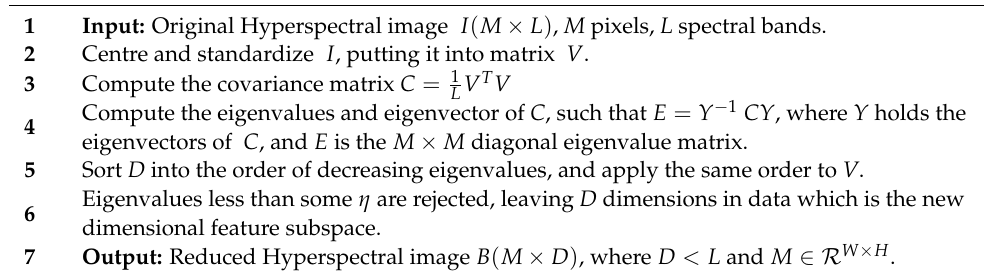
Algorithm 1: Principle Component Analysis (PCA )